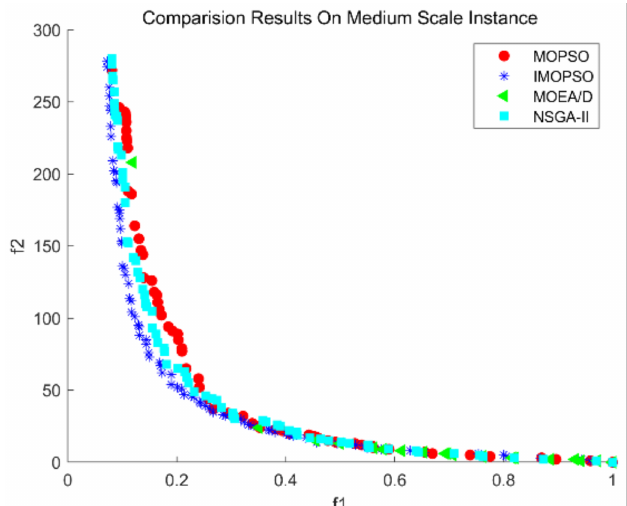
Figure 16. Comparison of four algorithms on medium-scaled instance.